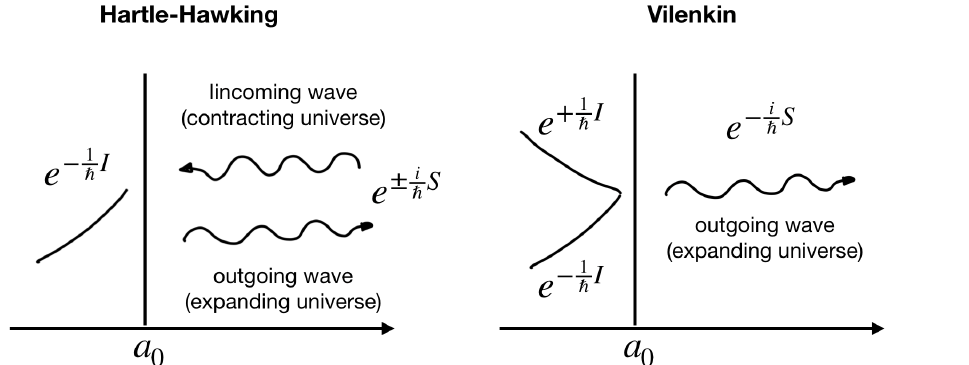
Figure 9. Hartle–Hawking “no-boundary” boundary proposal vs. Vilenkin’s tunnelling boundary proposal. The H–H state implies a linear combination of expanding and contracting wave functions in the Lorentzian region, where the tunnelling wave function corresponds only to expanding